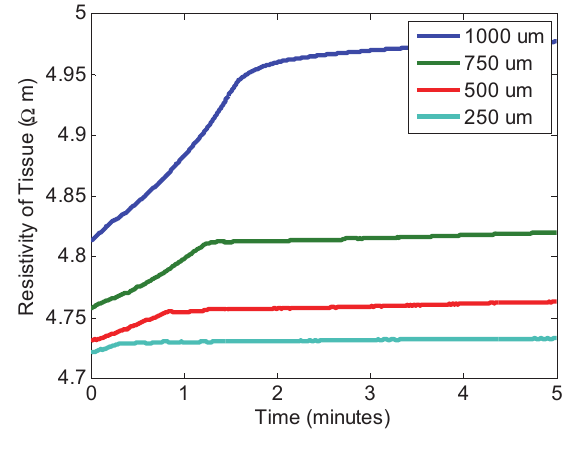
Fig. 18: Measured resistivity of alginate hydrogel encapsulated fibroblasts during large strain indentation experiments calculated from eq. 32. Legend denotes final indentation depth.